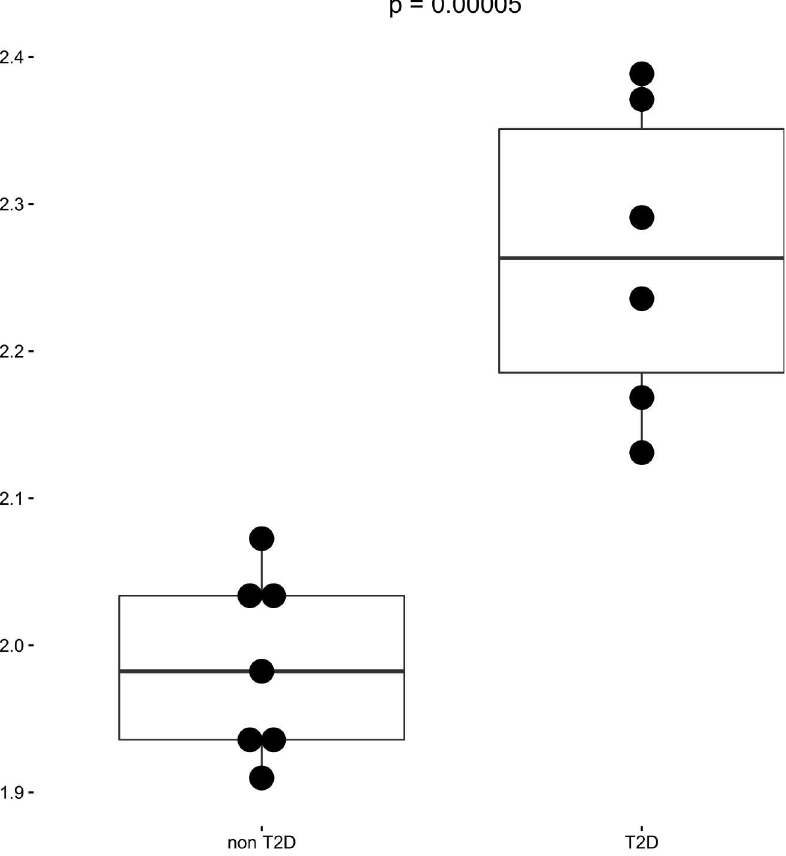
Fig 3. MUC5B differential expression in pancreatic islets from T2D and non-T2D organ donors. Displayed on the y axis are the mean and standard deviationvalues of log 2 transformation of expressiondata.